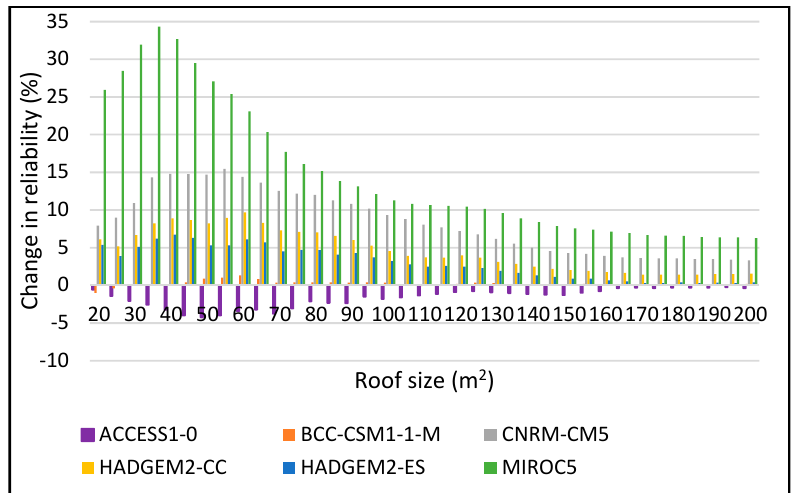
Figure 17. JJA Change in reliability for 5 m 3 during 2025–2055.